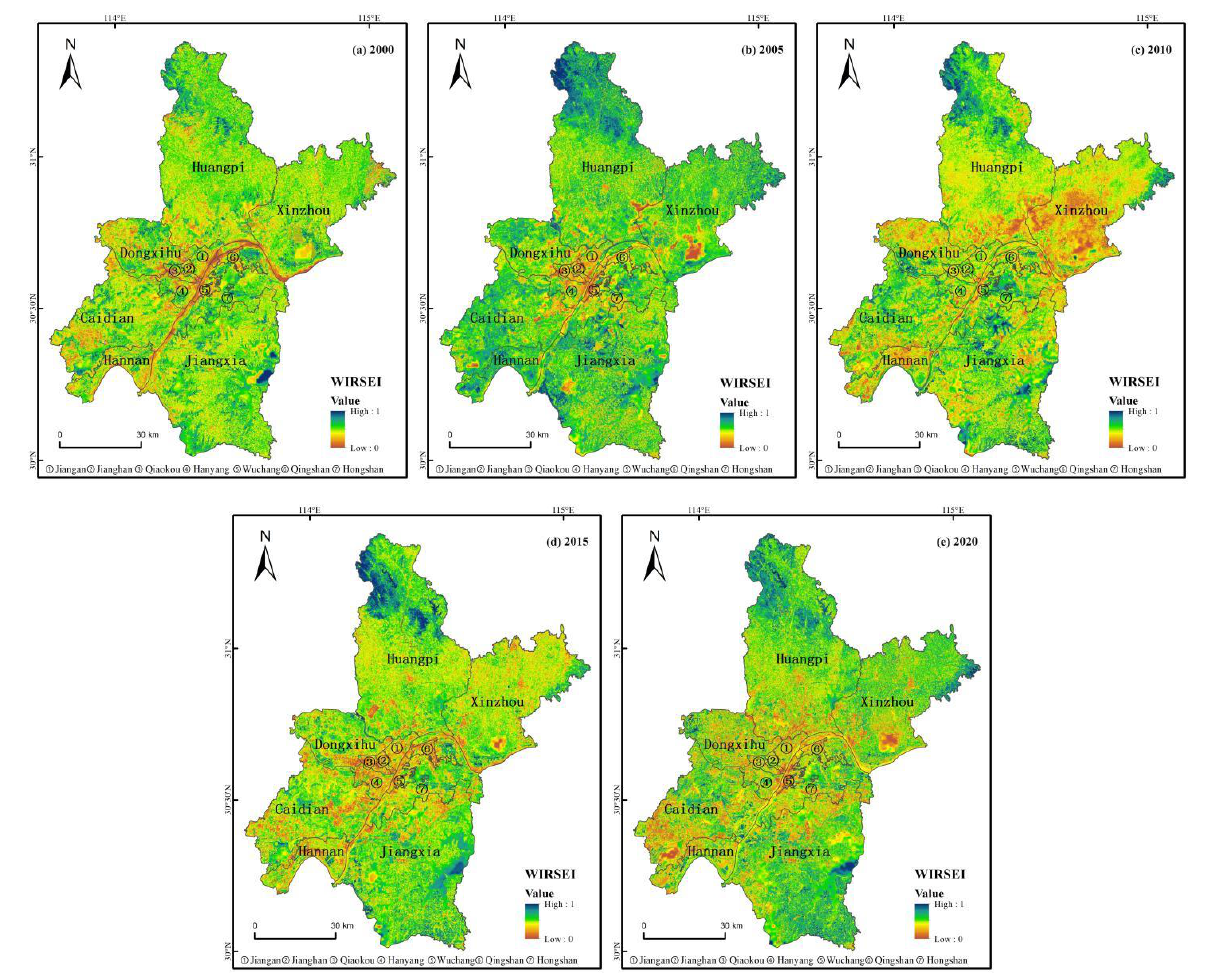
Figure 5. WIRSEI in Wuhan from 2000 to 2005: ( a ) 2000; ( b ) 2005; ( c ) 2010; ( d ) 2015; ( e ) 2020. Table 3. The WIRSEI in each district of Wuhan from 2000 to 2020.